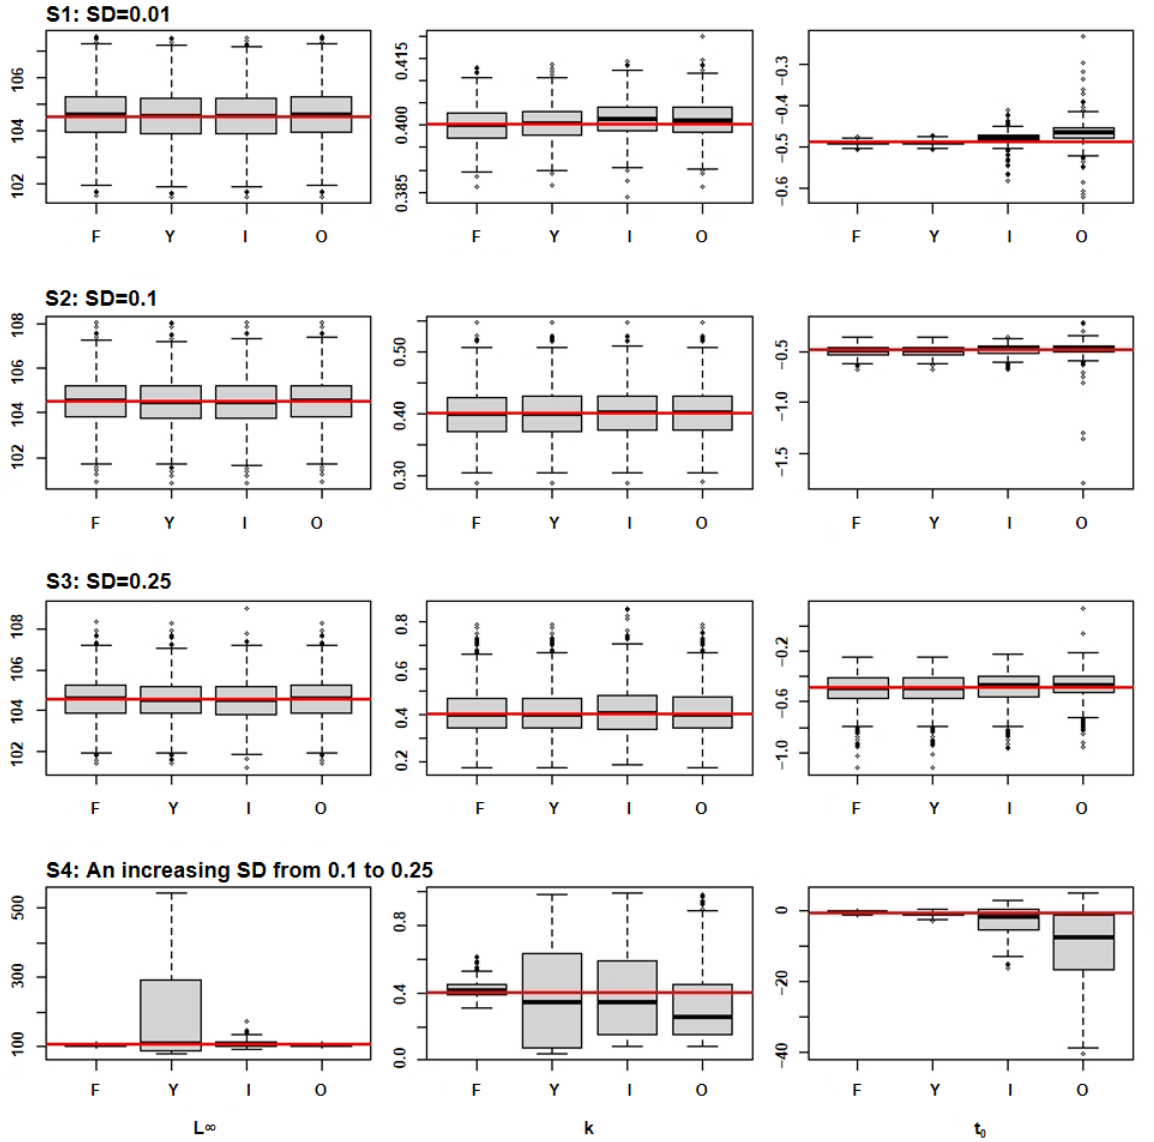
Figure 2. Distributions of estimated growth parameters of simulated albacore tuna (the red line is the initial parameter; L ∞ , k and t 0 are three parameters in the Von Bertalanffy growth model).